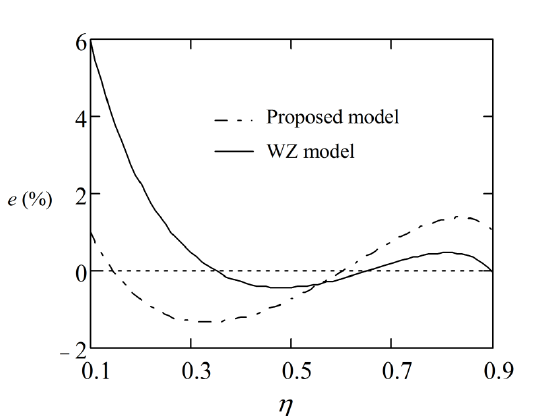
Fig. 4. Comparison of the errors in the estimated discharge of proposed and existing kinematic parameters for variable n value.